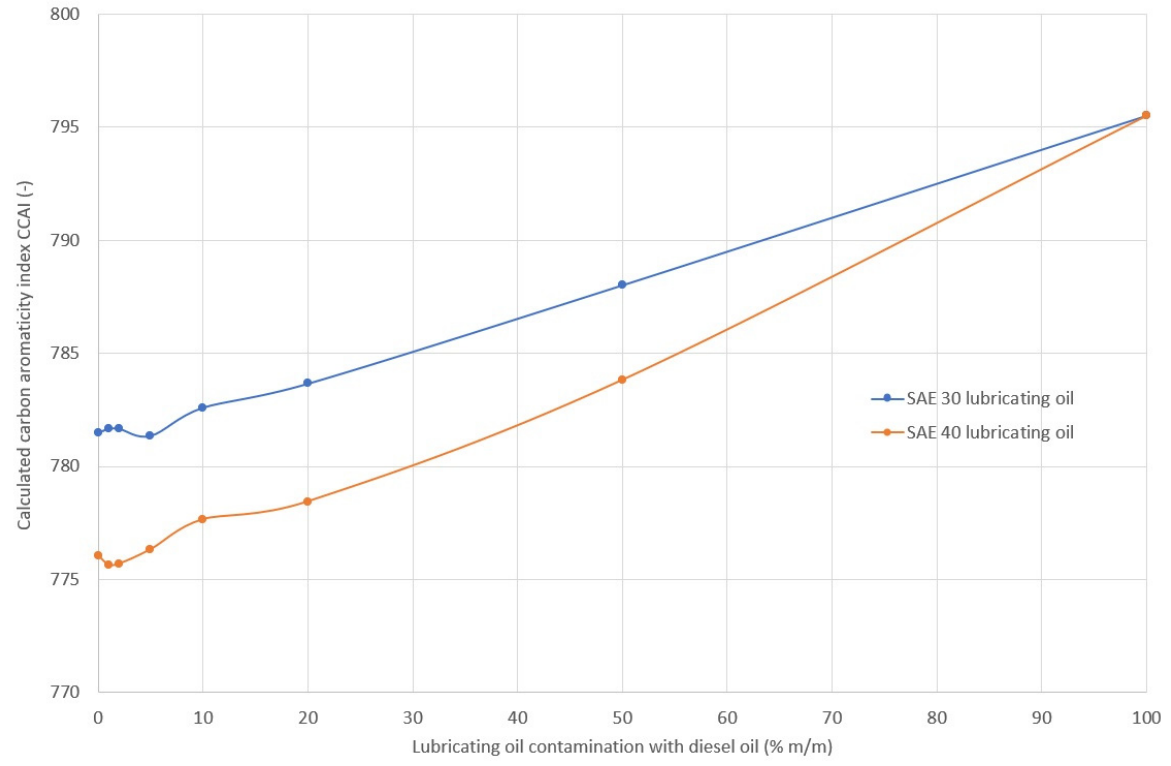
Figure 24. Calculated carbon aromaticity index of the tested lubricating oils at different levels of lubricating oil dilution with diesel fuel.